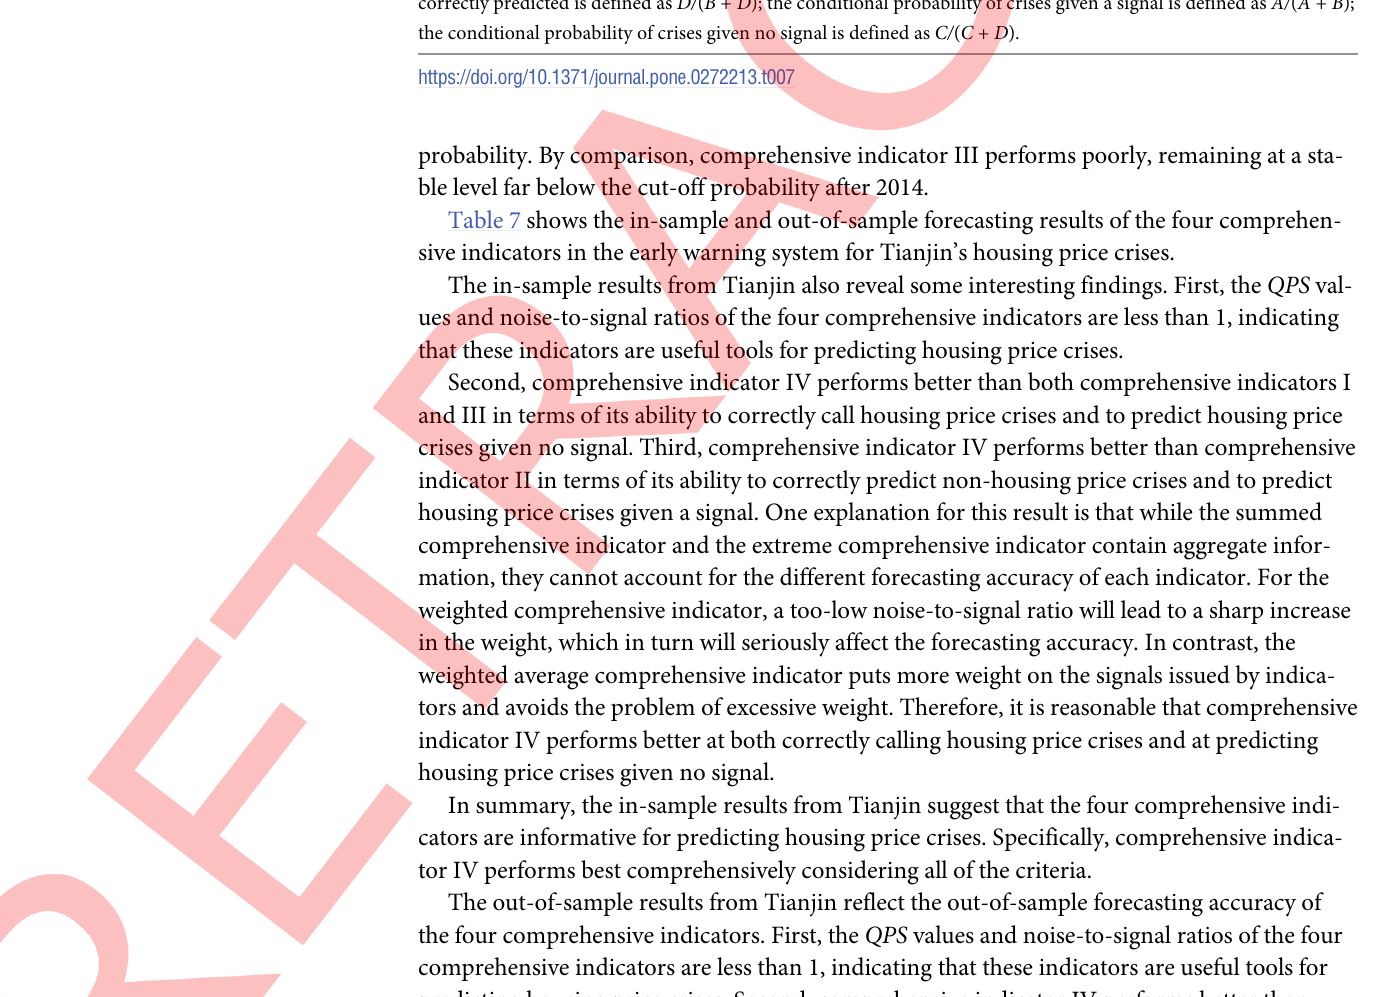
Table 7. Predictive ability from the comprehensive indicators. In-sample 2005Q3-2014Q2 Tianjin Comprehensive indicator Cut-off probability Noise-to-signal ratio Probability of crises correctly called 0.60 0.70 Probability of safety correctly predicted 1.00 1.00 Conditional probability of crises given a signal 1.00 Conditional probability of crises given no signal Noise-to-signal ratio Conditional probability of crises given a signal 0.50 Conditional probability of crises given no signal